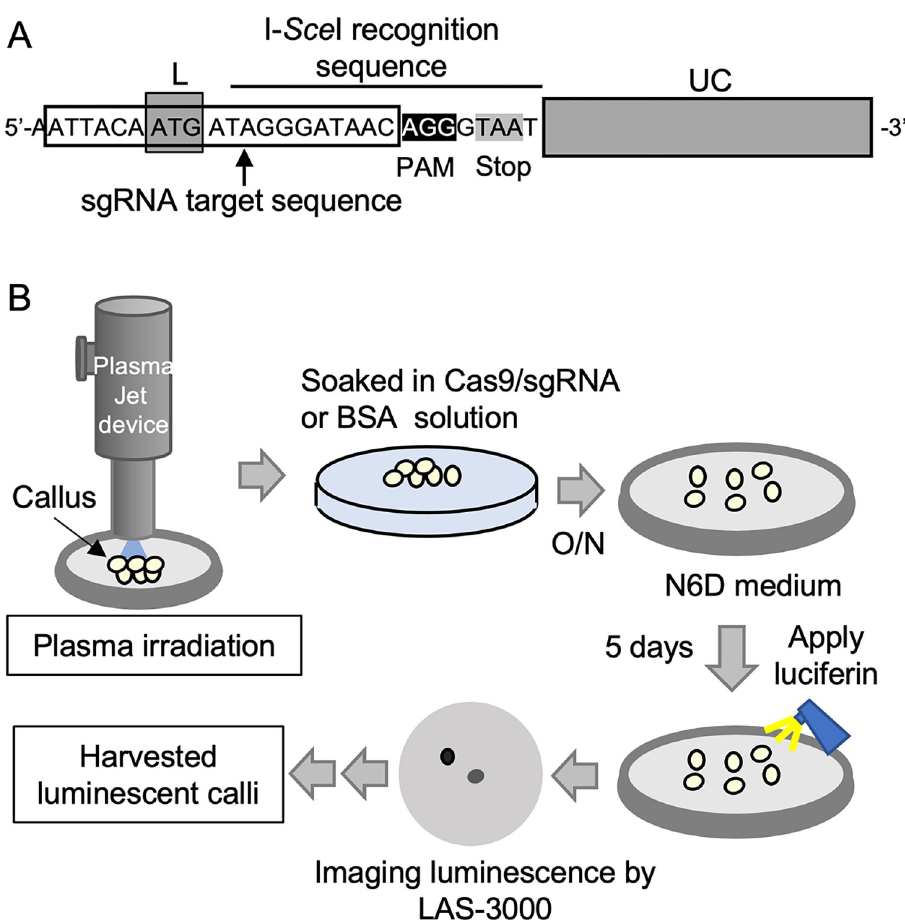
Fig 2. Rice reporter plant and procedure of the plasma treatment. (A) The structure of the L-(I-SceI)-UC reporter gene. The LUC gene was interrupted by the I- Sce I recognition sequence. sgRNA target sequence was designated as that comprising 20 nucleotides located immediately upstream of PAM sequence (AGG). Cas9/sgRNA digested at a site located approximately 3 to 4 base pairs upstream of PAM sequence. The LUC construct is inactive because the first ATG codon and LUC ORF was not located in-frame, and the translation was immediately terminated at stop codon (TAA) located just downstream of I- Sce I recognition sequence. LUC sequence can be changed in-frame when a frameshift occurs upon misrepair after digestion by Cas9/sgRNA, followed by demonstration of LUC chemiluminescence. (B) Scheme of generating genome-edited rice calli by introducing Cas9/sgRNA into the cells using plasma. Rice calli harboring the reporter gene were irradiated by N 2 or CO 2 plasma. The treated calli were soaked into Cas9/sgRNA or BSA solution and incubated overnight (O/N). After the calli were maintained for 5 days on the N6D medium plate, luciferin was sprayed to monitor the luminescent calli. The luminescent calli were cultured for 1 month and harvested. target sequence. The genome-edited DNA fragment that could not be cut by I- Sce I most likely had a size similar to that of the amplified fragment; however, it may have undergone consider- able insertion or deletion. As shown in Fig 3D, I- Sce I-resistant DNA fragments were obtained as bands of approximately 400 bp in the left and middle panels. Unlike them, a band of approx- imately 400 bp from the untreated reporter (Fig 3C right) was completely digested by I- Sce I in the right panel of Fig 3D, suggesting that the undigested fragments were produced by genome editing. To sequence the undigested bands, each digested sample was cloned into the cloning vector, as described in the Materials and Methods, and subsequent E . coli colonies were selected. Ten or 17 colonies were selected to prepare plasmid DNAs and for reading the sequences of DNA fragments in samples derived from calli 1 and 2, respectively, as shown in